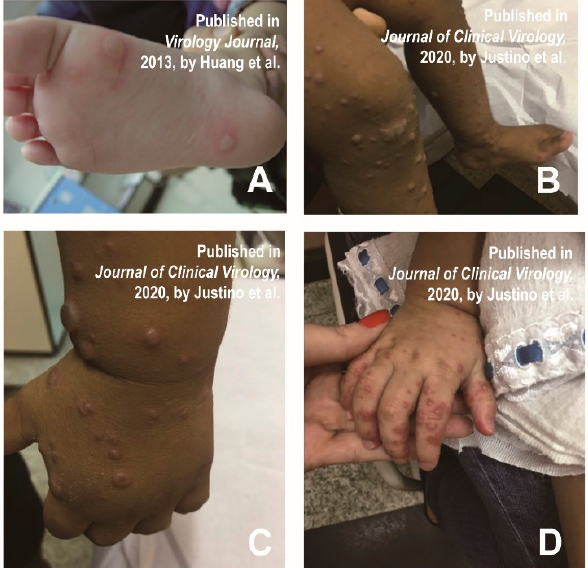
Figure 4. ( A ) Bullae were formed on a sole, accompanied by mild pruritus and prickling sensations. Reprinted/adapted with permission from Ref. [35]. 2013, Huang et al. ( B – D ) Bullous lesions on the extremities (knees and/or elbows) in patients with atypical HFMD. Reprinted/adapted with permission from Ref. [36]. 2020, Justino et al.